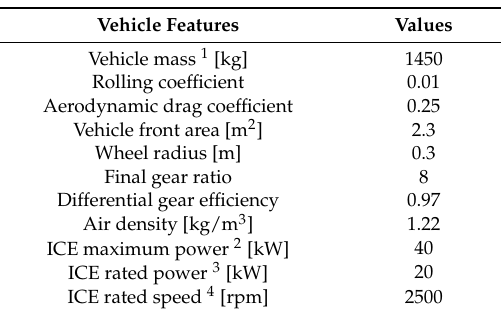
Table 1. Vehicle features.